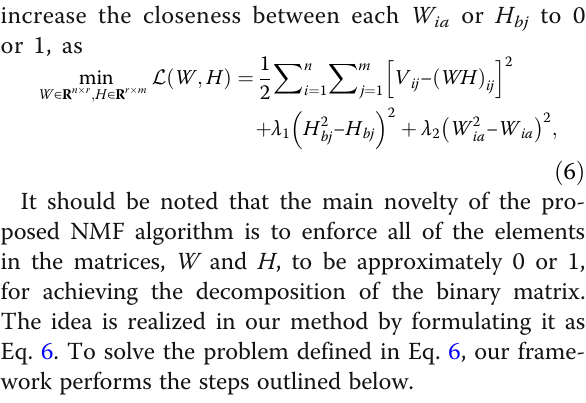
4 Proposed NMF algorithm for binary image